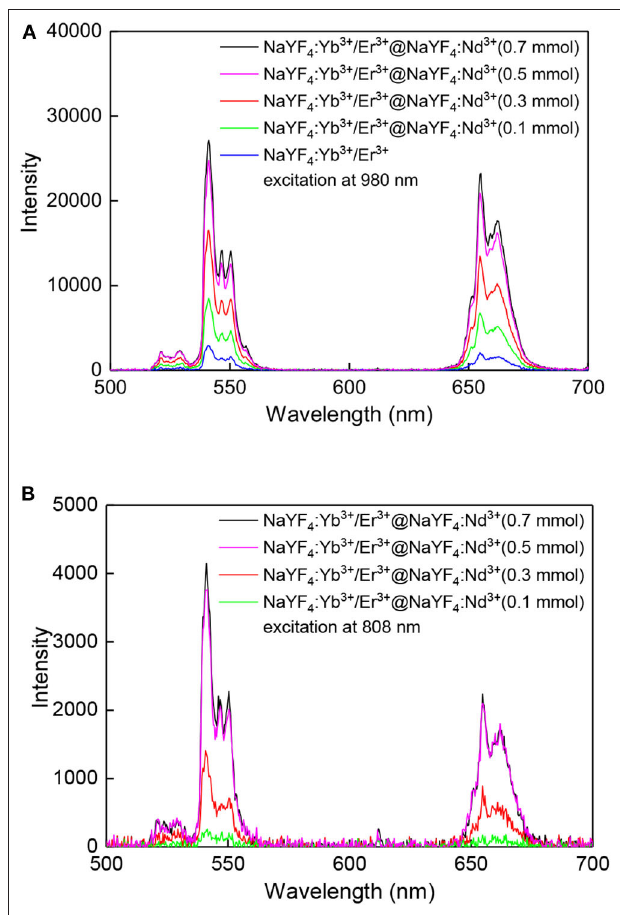
FIGURE 4 | Upconversion photoluminescence spectra of nanoparticles (1mg/ml) in hexane/water emulsion stabilized with Igepal CO-520 at (A) 980 and (B) 808nm excitation; average power density of both lasers ∼ 30 W/cm 2 .